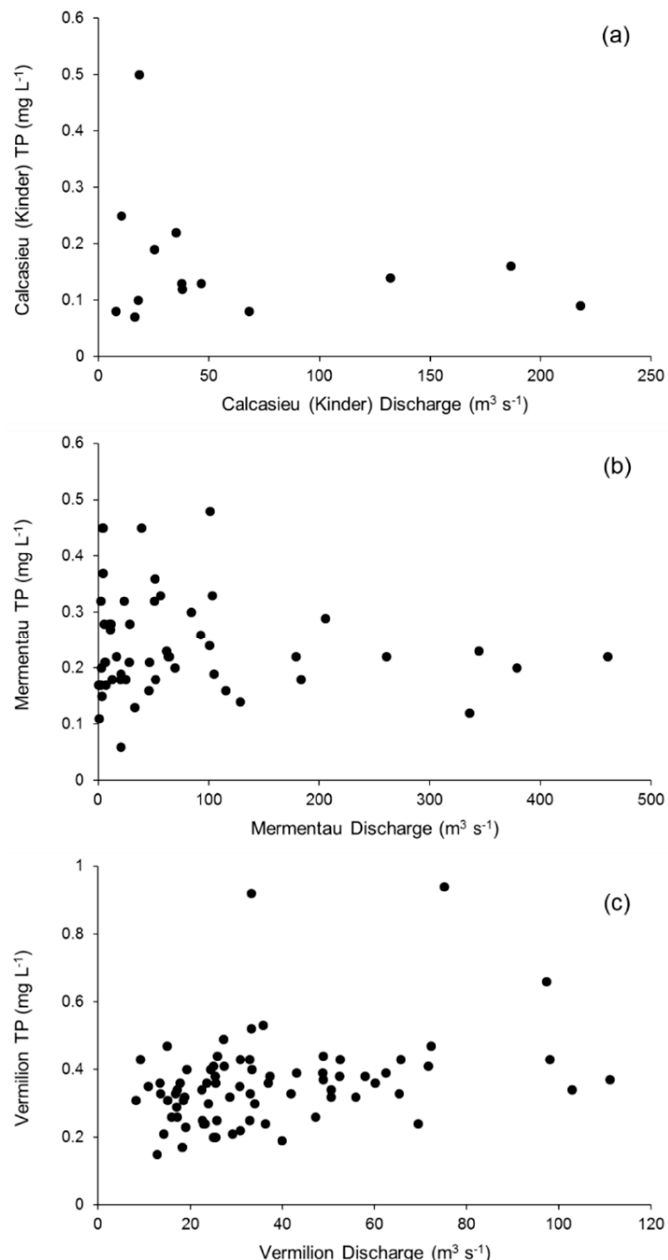
Figure A6. The relationship between discharge and TP concentration for the Calcasieu ( a ), Mermentau ( b ), and Vermilion ( c ) Rivers from 2010 to 2017 using discharge data from USGS and TP concentration data from Louisiana Department of Environmental Quality (LDEQ).